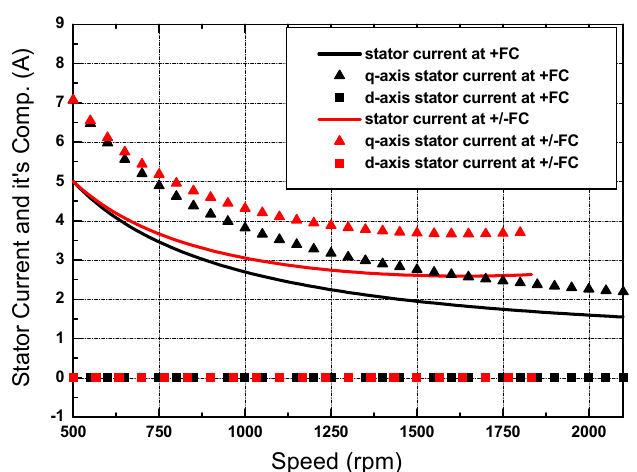
Figure 9. Stator voltage and EMF at reduced and reversed FC.